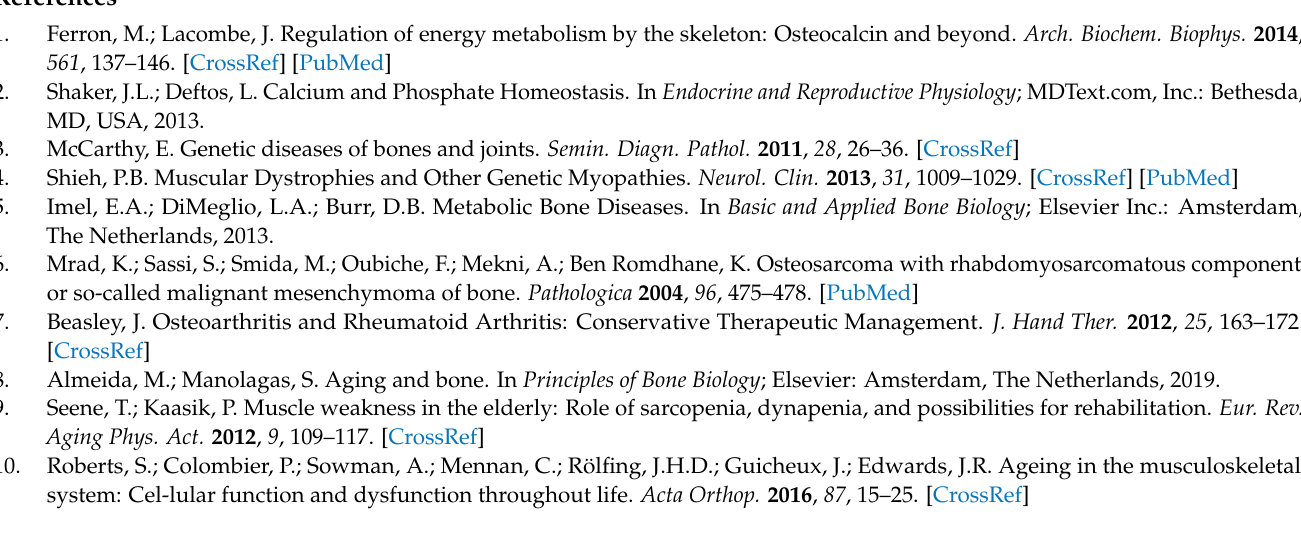
analysis relative to Figure